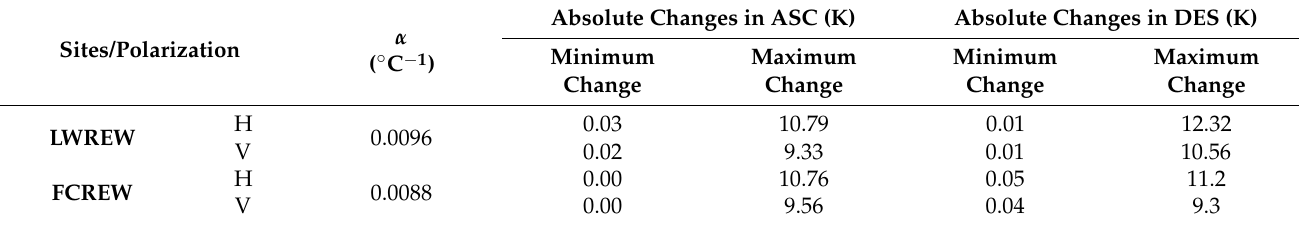
Table 5. The variations of soil TB at all polarizations at both ascending and descending nodes at all sites.